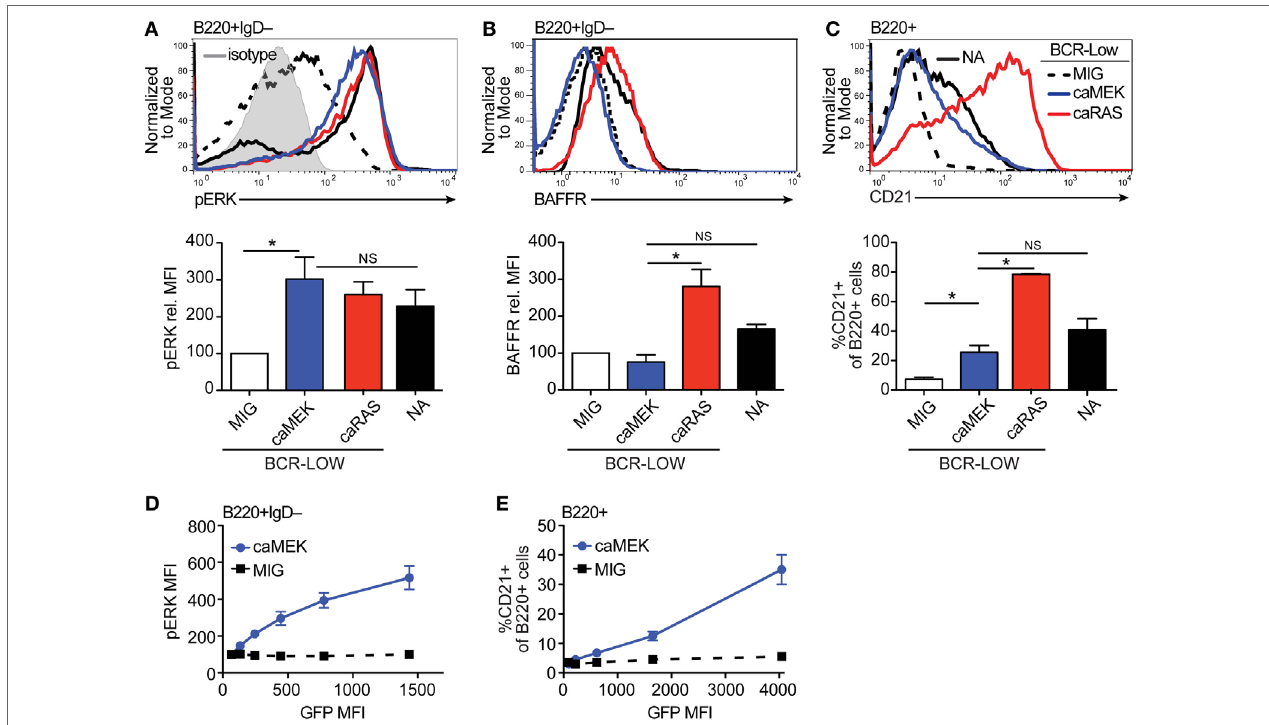
FigUre 2 | Extracellular signal-regulated kinase (ERK) activation drives differentiation of BCR-low immature B cells in vitro . (a,B) Representative histograms and bar graph quantification of pERK (a) and BAFFR (B) in bone marrow immature (B220 + IgD – ) B cells cultured for 4 days with IL-7. The cells analyzed were either nonautoreactive (NA) (3-83Igi,H-2 d ) BCR normal cells (NA, black solid line) or BCR-low cells transduced with MIG (black dashed line), caMEK (blue line), or caNRas (red line). The analysis of transduced cells was performed on GFP + cells in all experiments. Staining of pERK was done on cells treated with pervanadate to allow for pERK signal detection. The gray shaded histogram in (a) represents isotype control antibody. (c) Representative histograms and bar graph quantification of the frequency of CD21 + cells in the B220 + B cell population after 3 days of culture with BAFF. (D,e) BCR-low B cells transduced with either caMEK (blue) or MIG control (black) were gated based on increasing GFP expression, which correlates with caMEK expression in caMEK transduced cells. The pERK MFI (D) or the frequency of CD21 + cells (e) were plotted against the GFP MFI of the individual segments. In all panels, N = 3 total, from three independent experiments. * P ≤ 0.05; NS, not